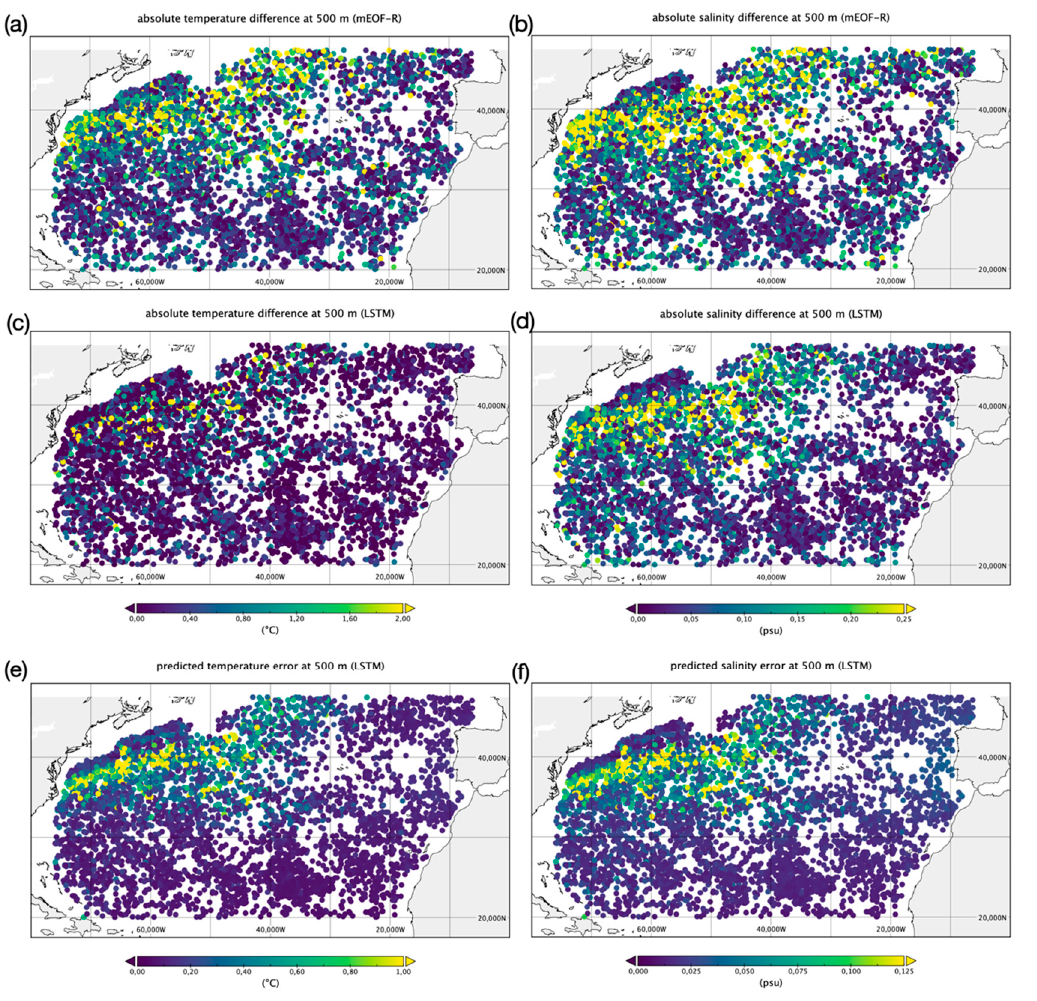
Figure 5. Absolute value of the differences between mEOF-r temperature ( a ) and salinity ( b ) and observed test data at 500 m depth, and corresponding LSTM (35–35) differences ( c , d ). Temperature ( e ) and salinity ( f ) predicted LSTM (35–35) reconstruction error at 500 m.